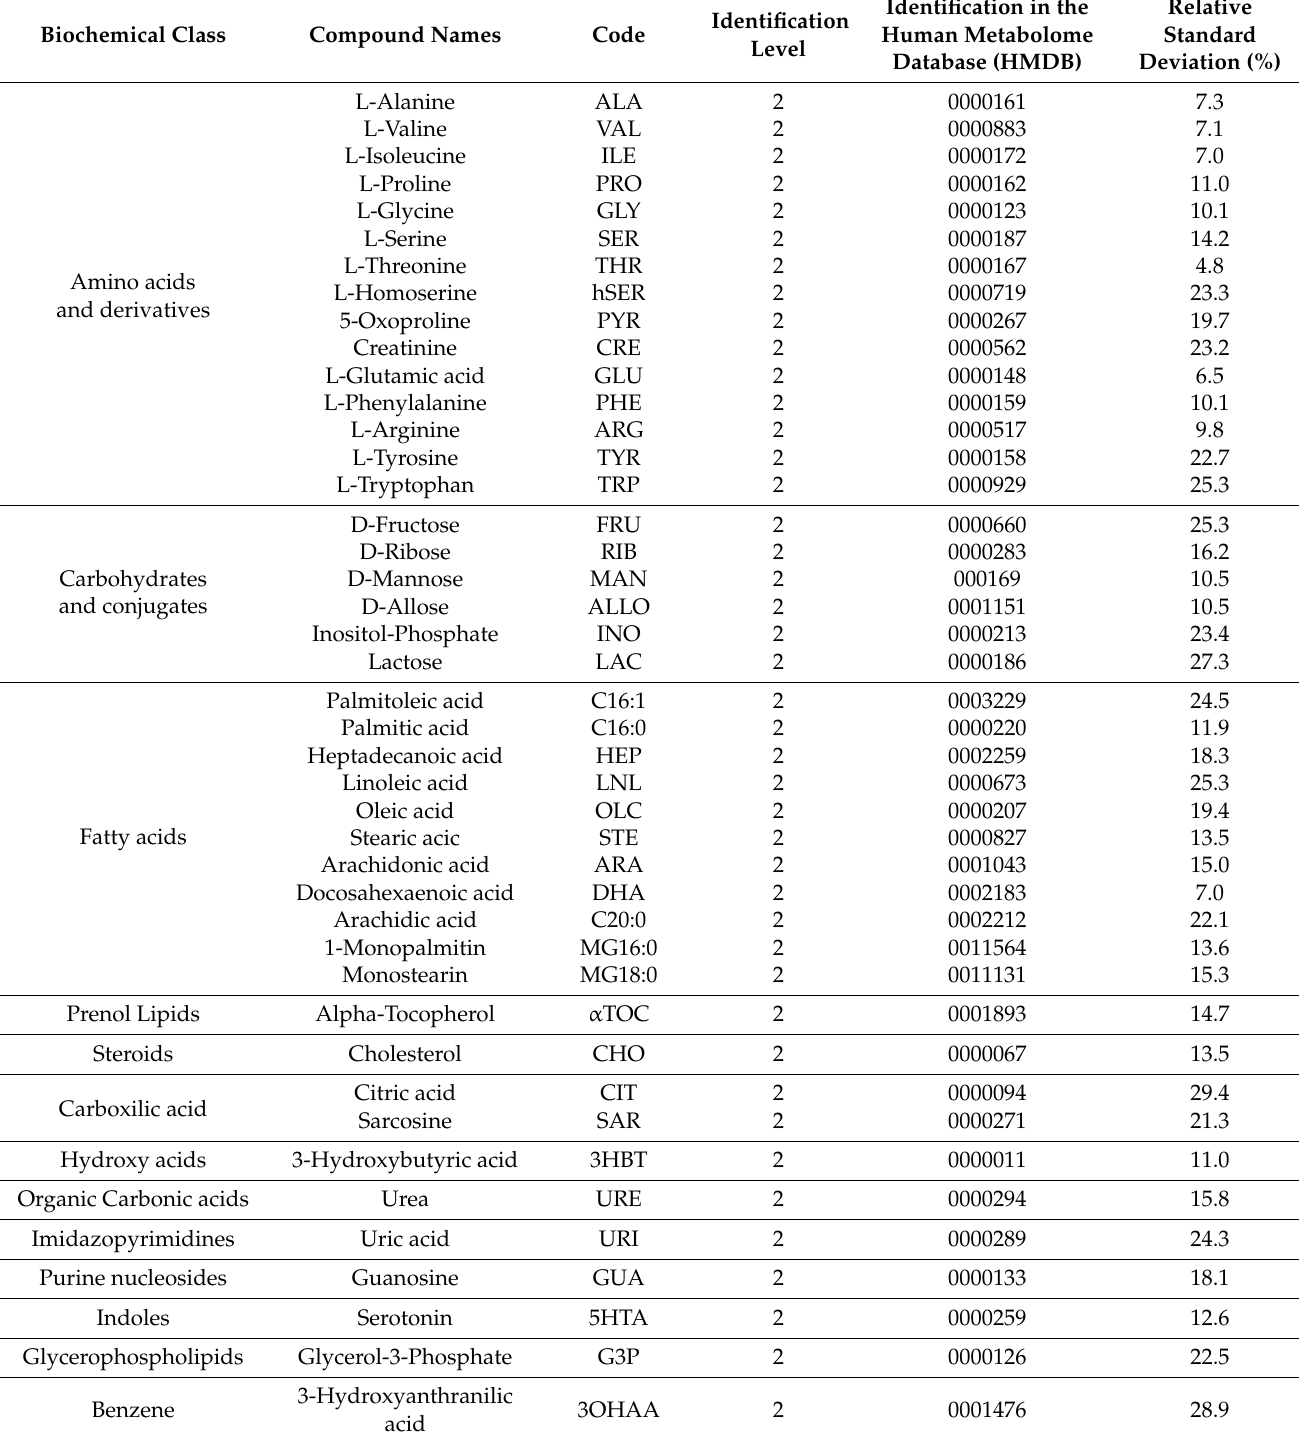
Table 3. Description of all metabolites identified in the serum, grouped by their biochemical